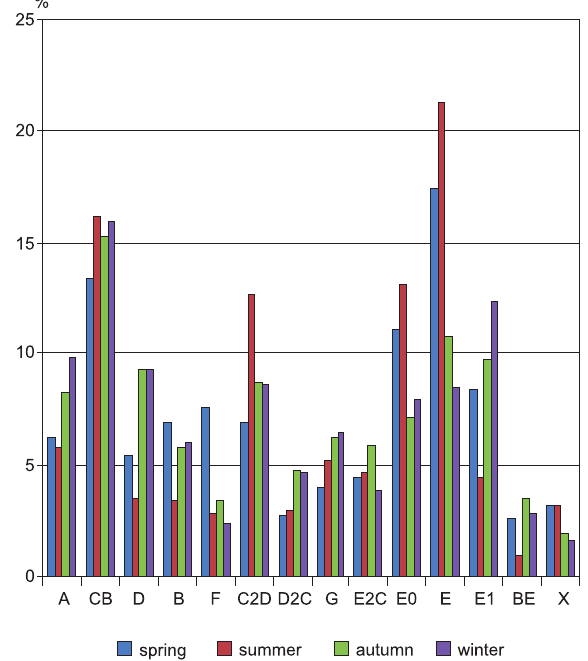
Fig. 3. Frequency of occurrence of atmospheric circulation types in seasons according to Osuchowska-Klein